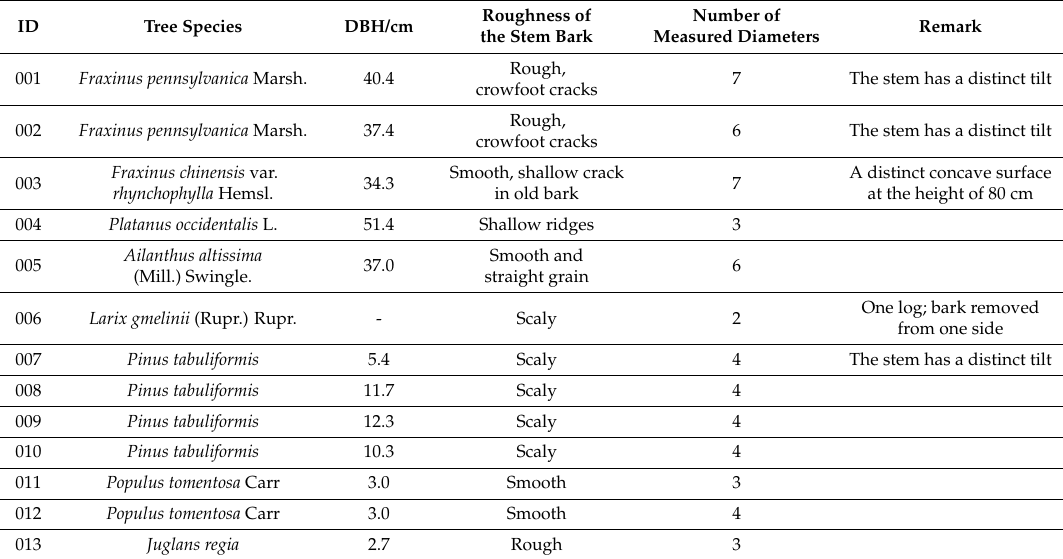
Table 2. Basic information about the measured